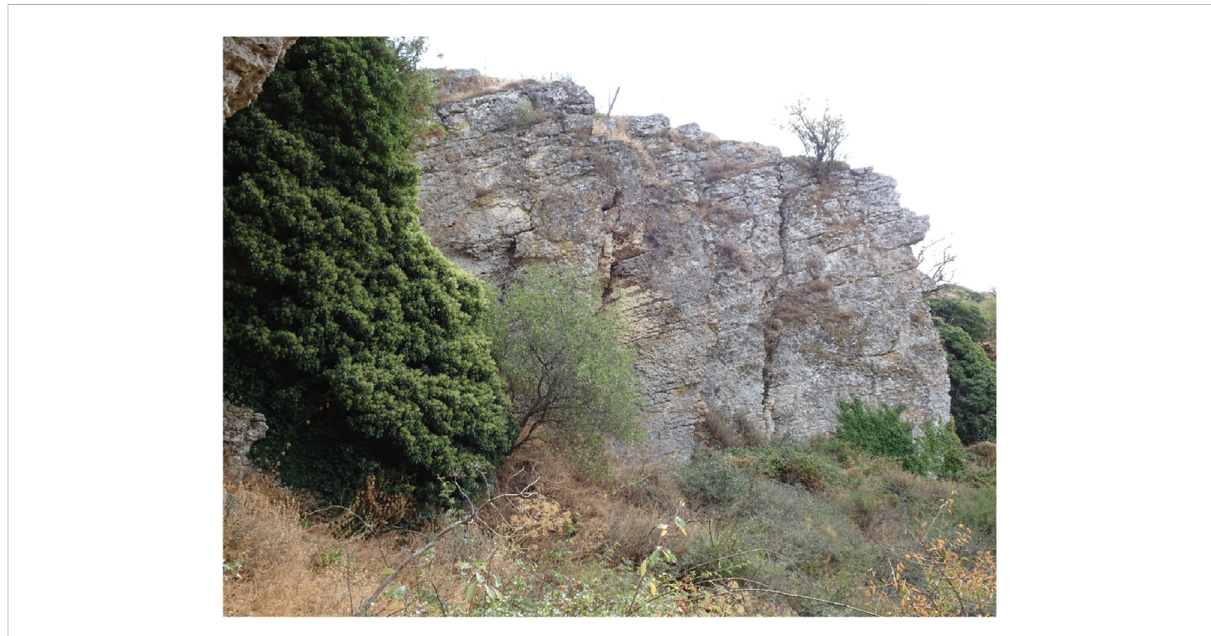
FIGURE 6 Large-scale planar cross-bedded coralline algal rudstone at Section 7. Beds are dipping to the